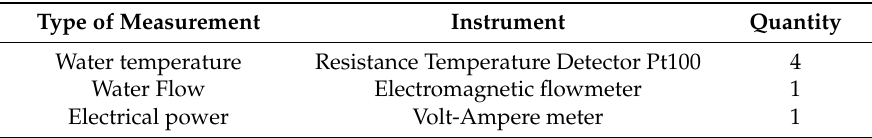
Table 2. Sensors of the hot and cold water generation system.